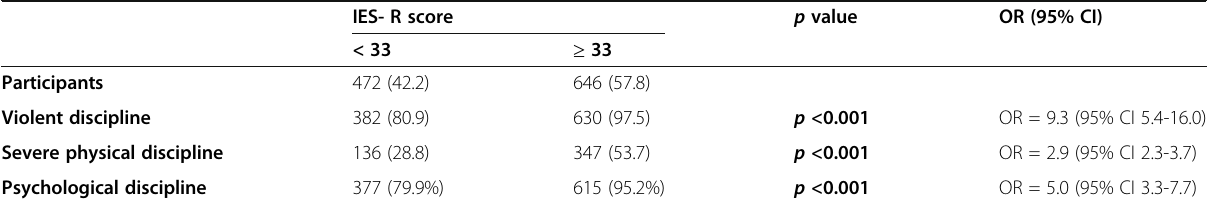
Table 4 Final model logistic regression analysis of psychological impact related to COVID-19 pandemic and violent discipline